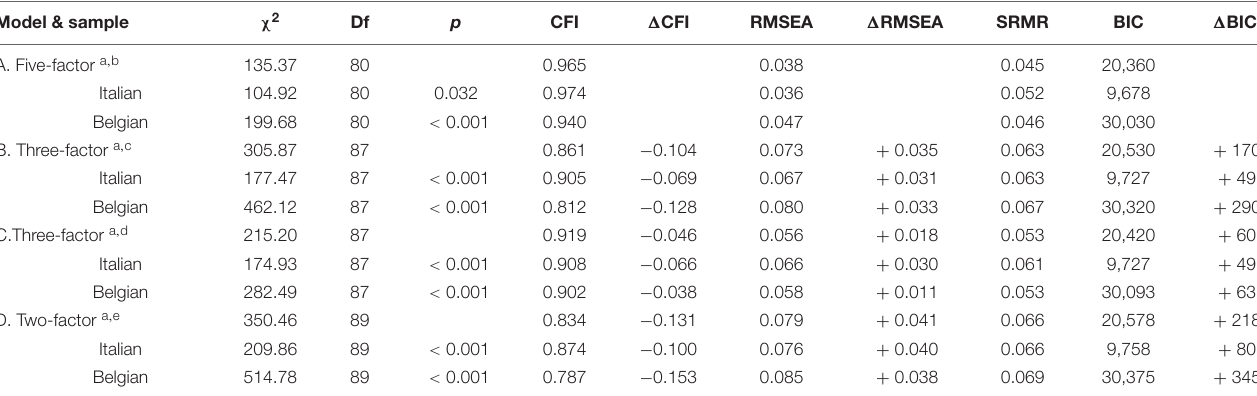
TABLE 1 | Confirmatory factor analyses fit indices for models with five to two factors for total, Italian, and Belgian sample. Model & sample